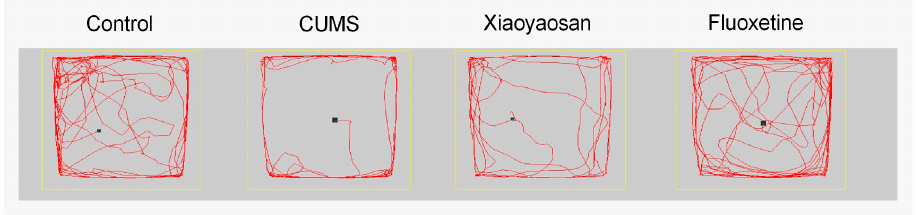
Figure 4. The movement trails of mice in each group at day 21 assessed by video tracking software in the OFT that displayed the locomotor function.